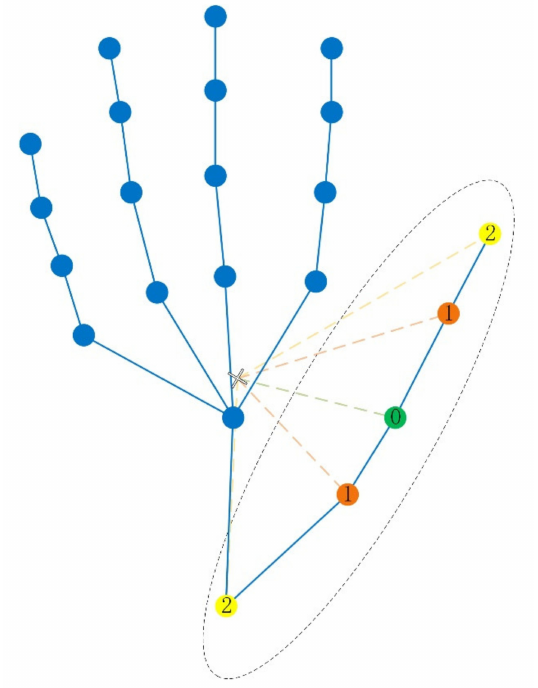
Figure 6. New partition strategy for constructing convolution operations.